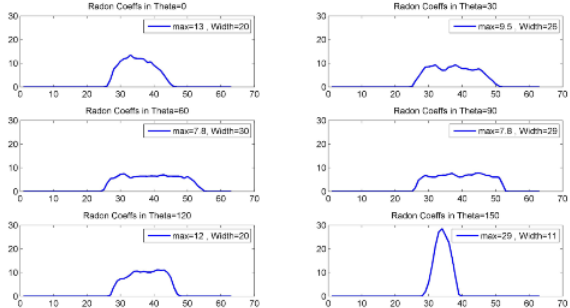
Figure 6. Radon coefficients of the selected block in different